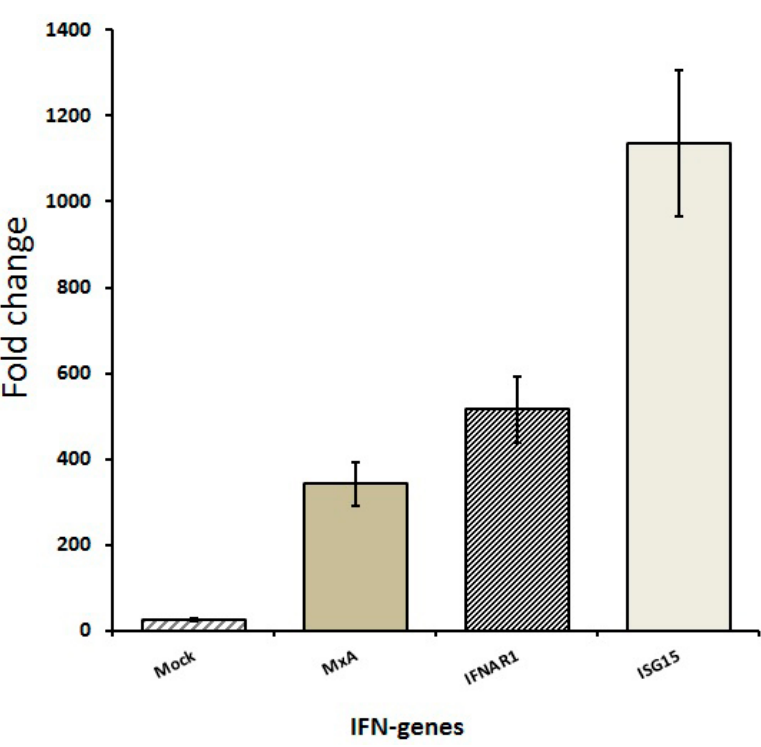
Figure 3. Human mycovirus resistance protein 1 (MxA), Interferon- α / β receptor α chain gene (IFNAE) 1 and interferon stimulated gene 1 (ISG15) production from A549 cells after incubation with HD1 fecal water.